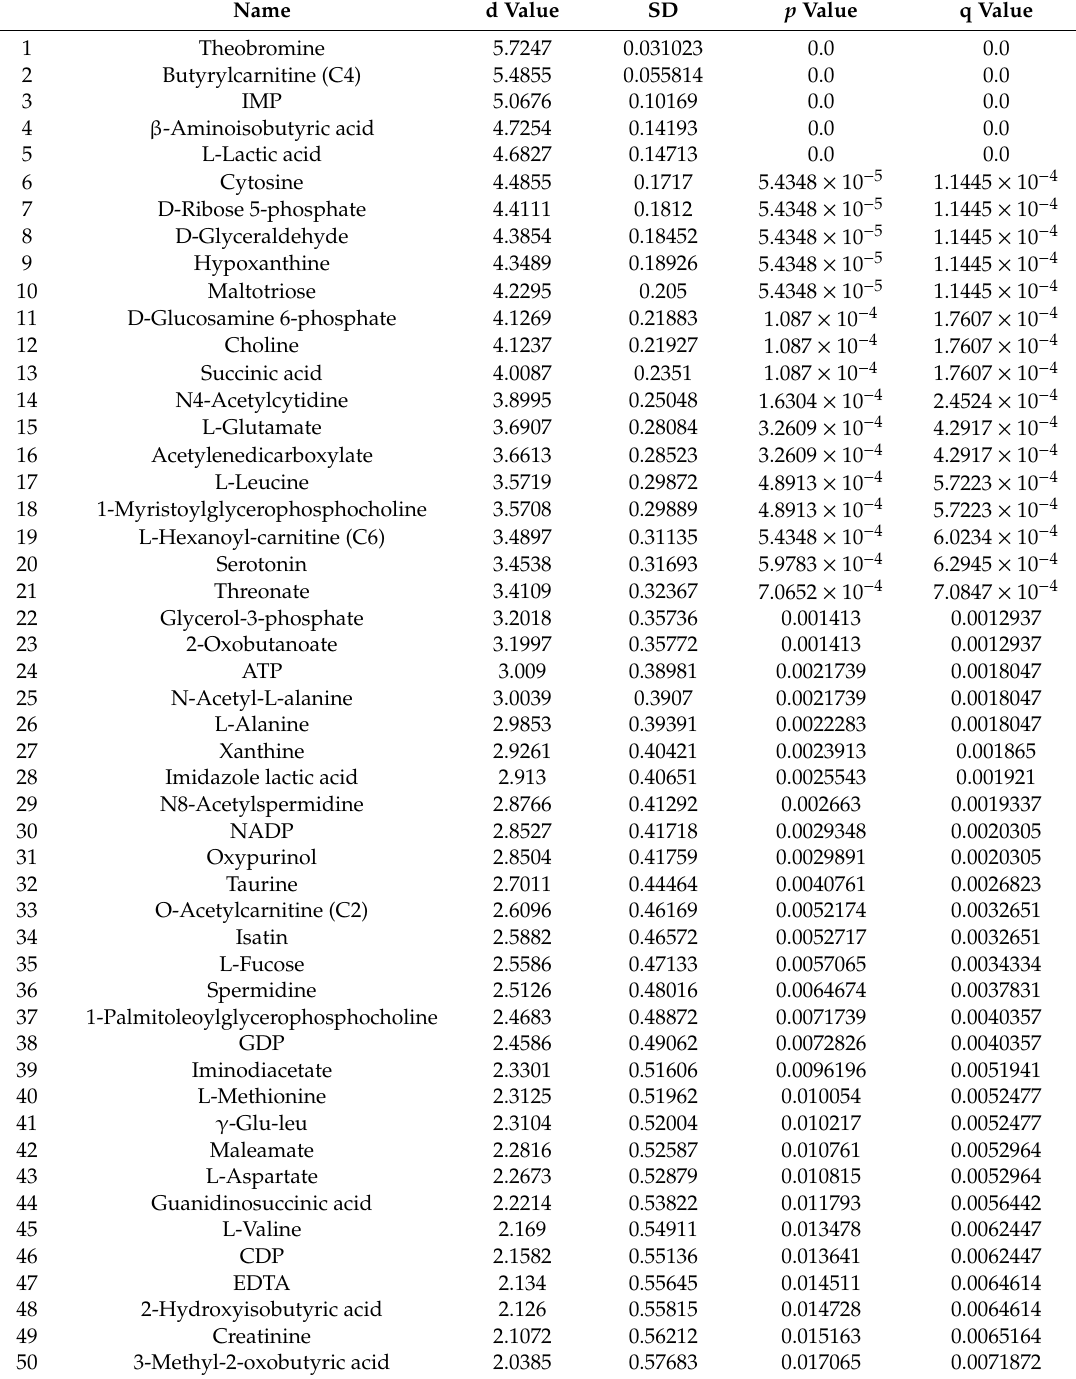
Table 1. Significant features identified by